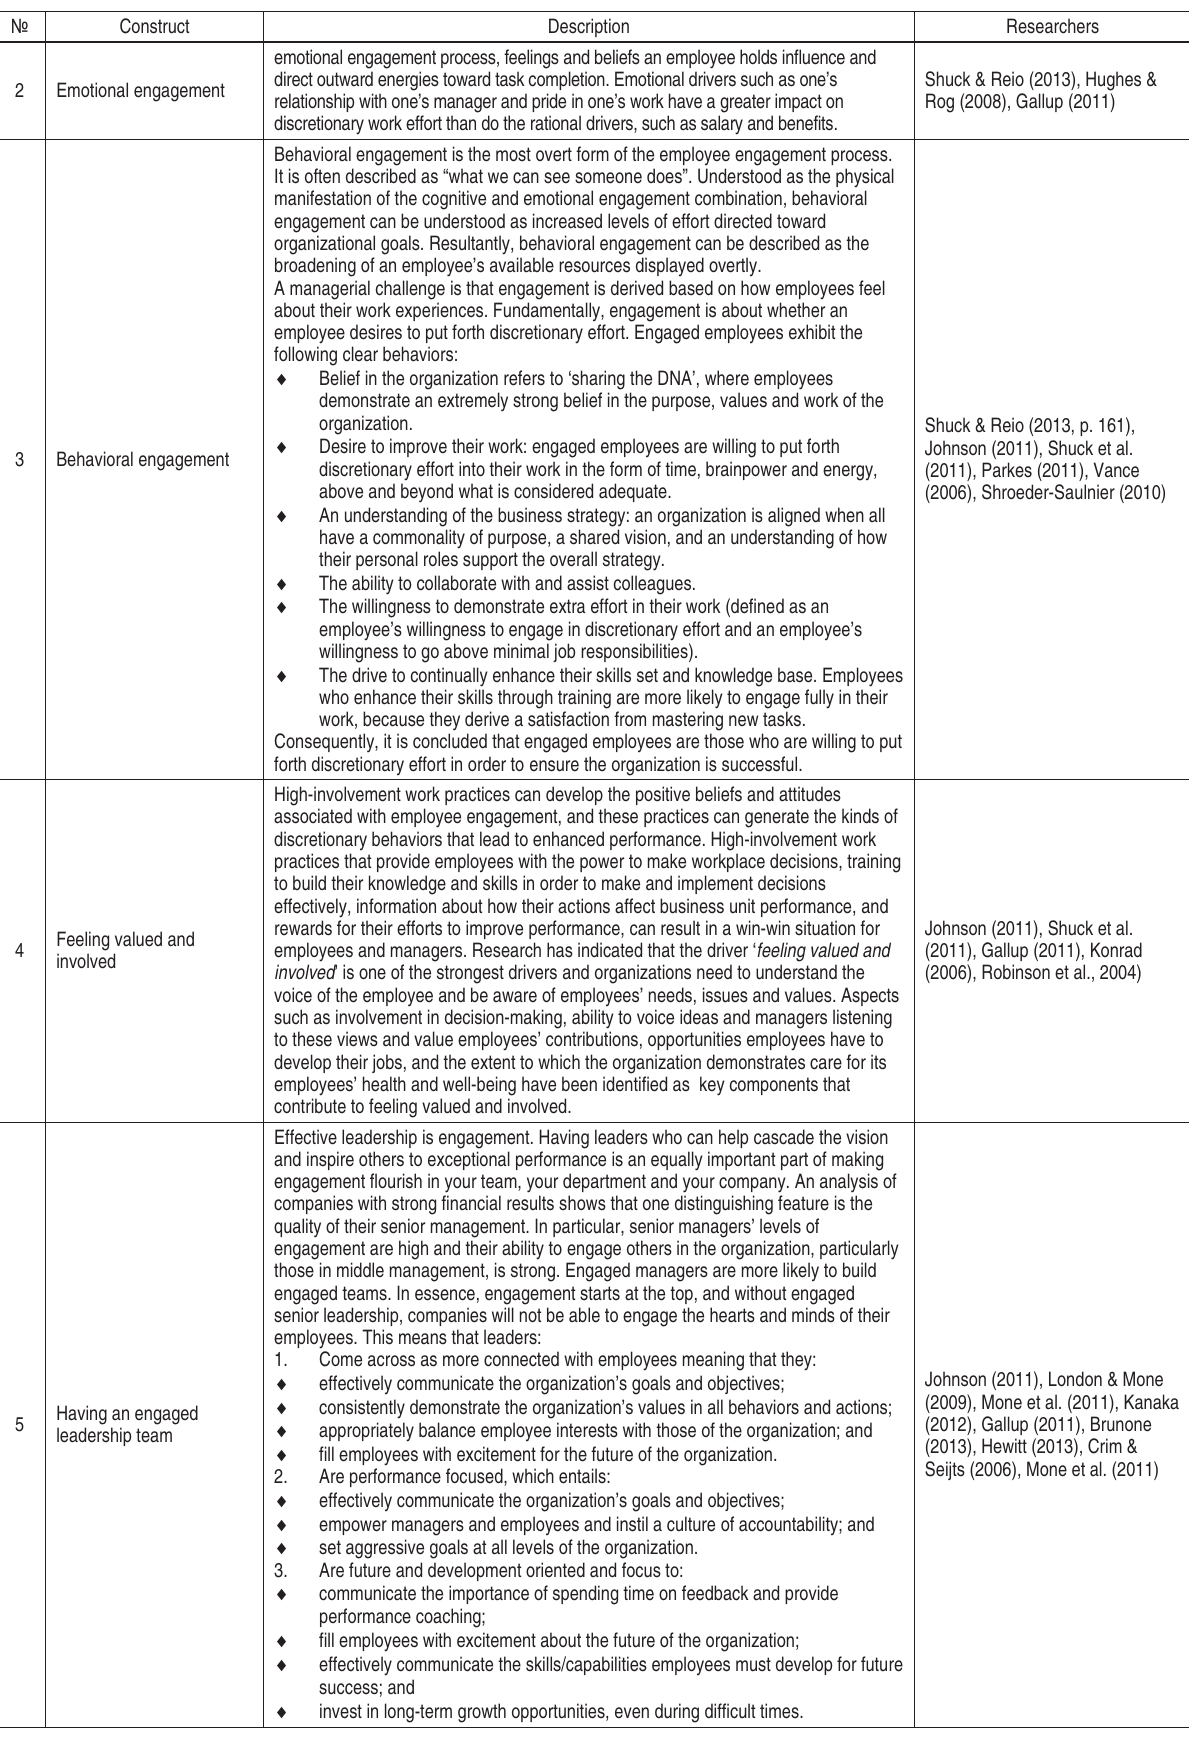
Table 1 (cont.). Employee engagement